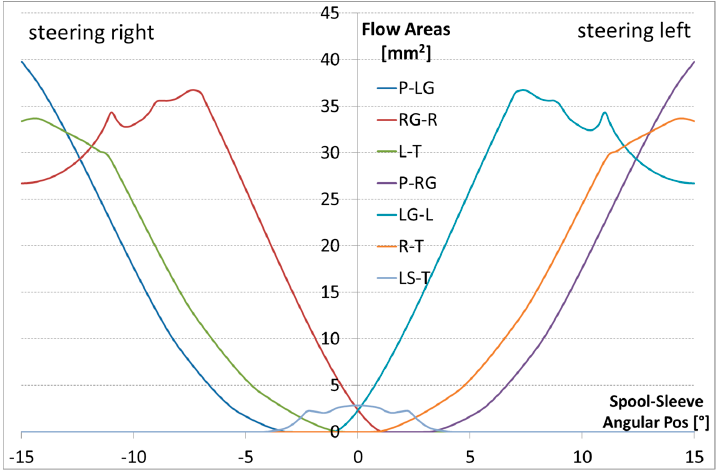
Figure 4. Rotary valve flow areas trends as function of the relative angular position between the spool and the